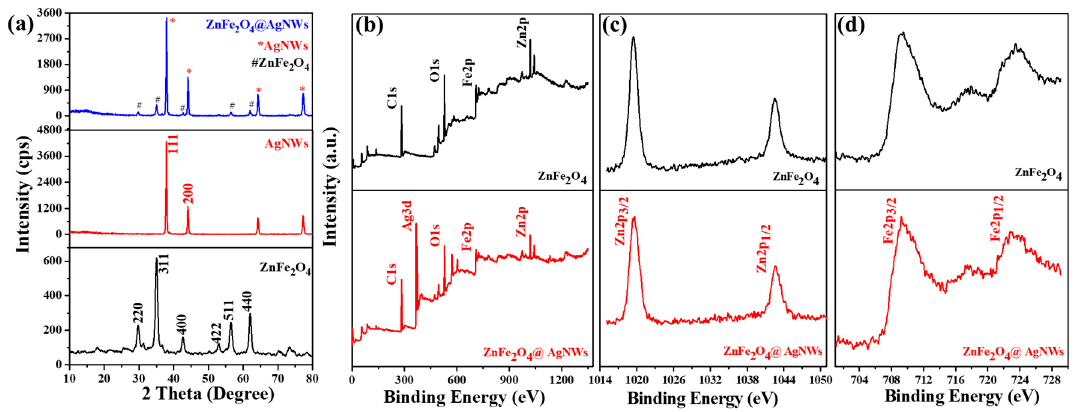
Figure 3. ( a ) XRD patterns of pure ZnFe 2 O 4 NPs, AgNWs, and ZnFe 2 O 4 @AgNWs hybrid nanostructures. ( b–d ) XPS spectra of ZnFe 2 O 4 NPs and ZnFe 2 O 4 @AgNWs hybrid nanostructures: ( b ) overall scans, ( c ) magnified spectra focused on Zn 2p levels, ( d ) magnified spectra focused on Fe 2p levels.